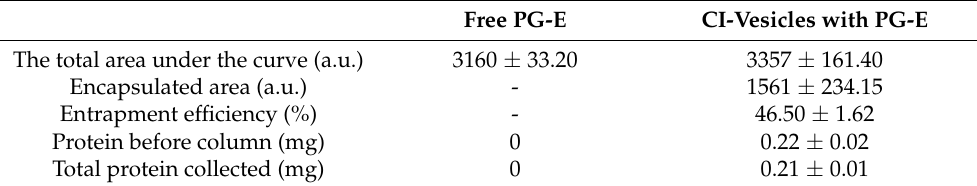
Table 3. Entrapment efficiency calculated from absorbance data and the protein content (mg) in samples before and after passage through a Sephadex column and fractions collection. Free PG-E CI-Vesicles with PG-E The total area under the curve (a.u.) 3160 ± 33.20 3357 ± 161.40 Encapsulated area (a.u.) - 1561 ± 234.15 Entrapment efficiency (%) 46.50 ± 1.62 Protein before column (mg)